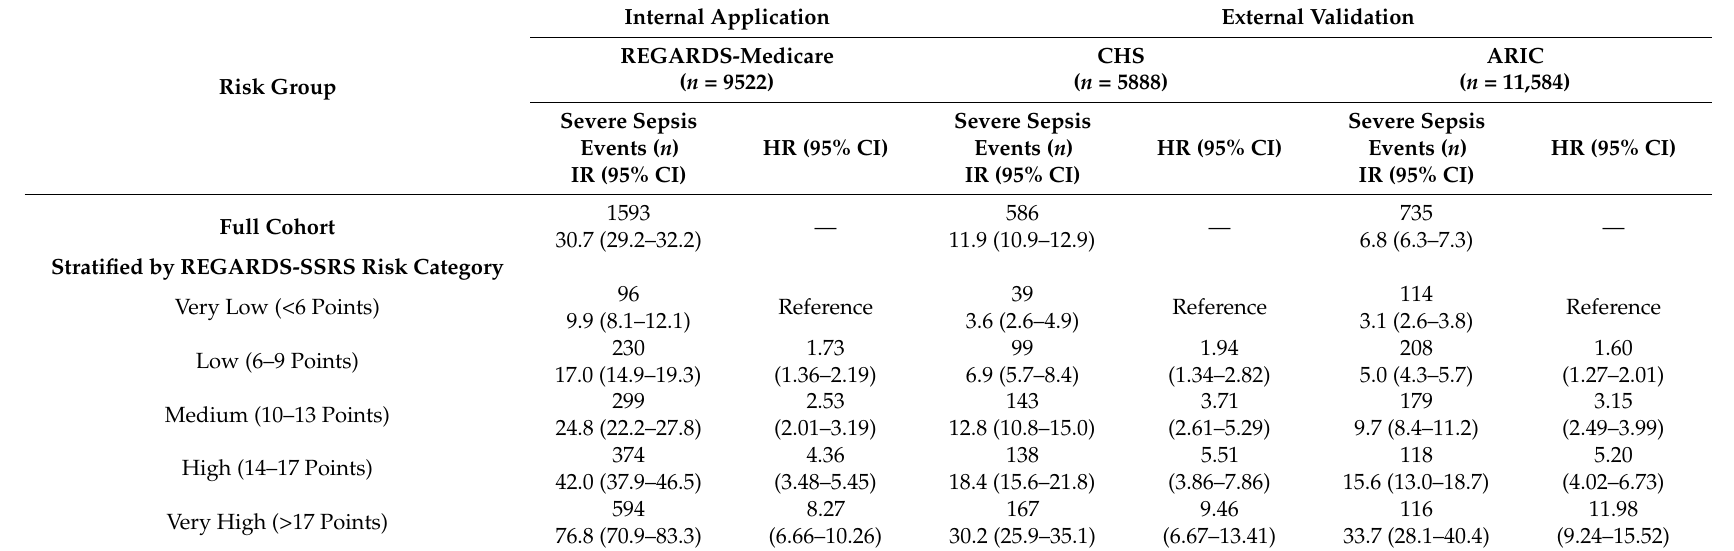
Table 3. Severe sepsis incidence for each cohort, overall and stratified by REGARDS-Severe Sepsis Risk Score risk